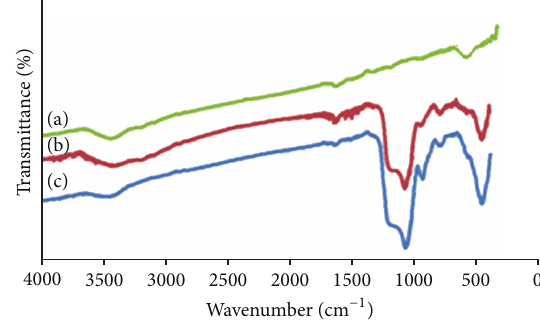
Figure 7: FT-IR spectra of (a) bare ZnS nanoparticles, (b) ZnS@SiO 2 core-shell nanocomposites, and (c) hollow SiO 2 nanos- tructures.